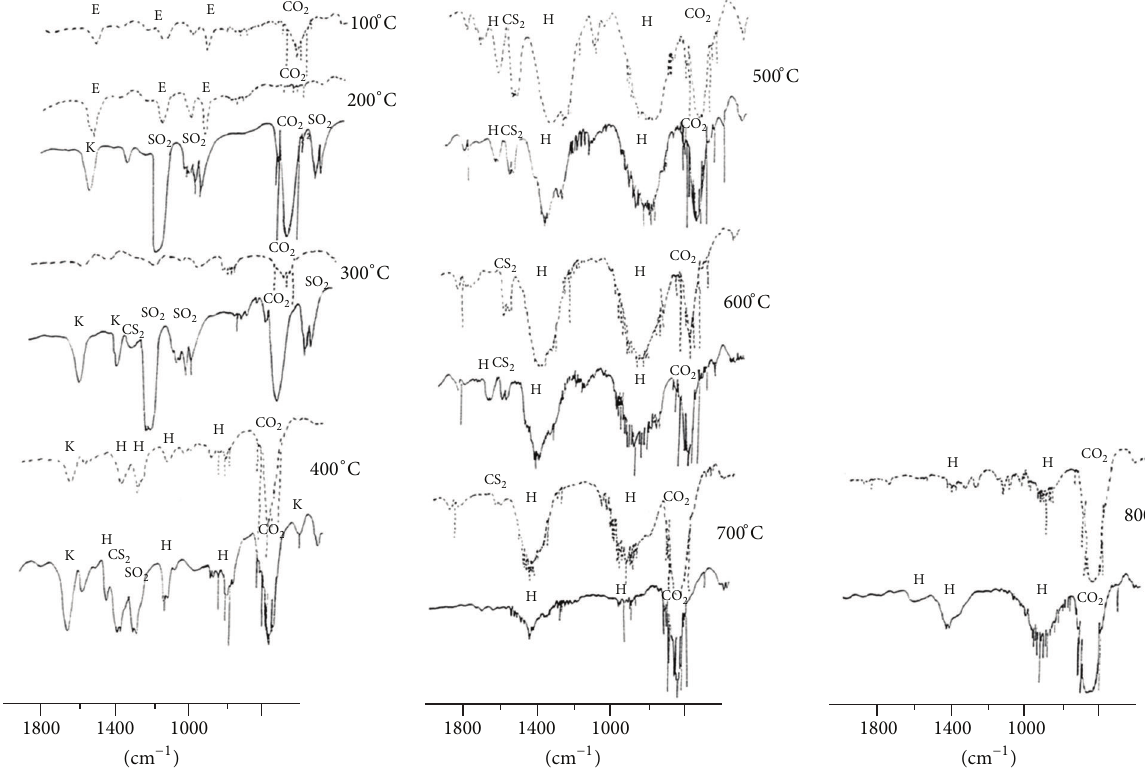
Figure 6: FT-IR spectra in the 2000–400 cm −1 region of gases obtained at different temperatures from Sulcis (—) and South Africa (---) coals sampled in the cooling trap (c). E = ethers, K = ketones, H = aliphatic hydrocarbons (saturated and unsaturated).